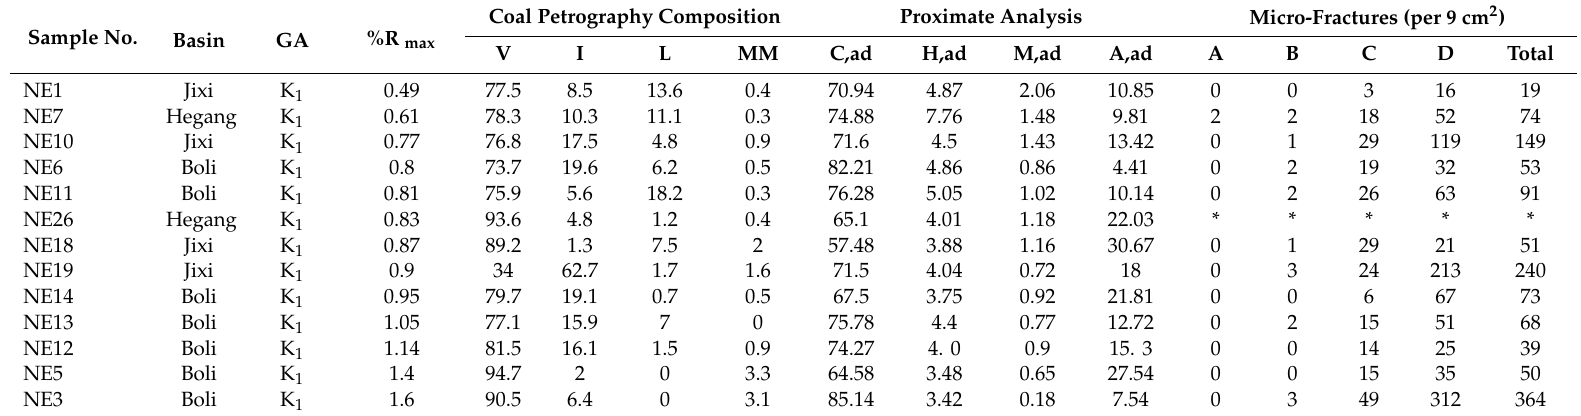
Table 1. Proximate analysis and micro-fracture analysis of selected coals from Sangjiang-Muling coal-bearing basins. Sample